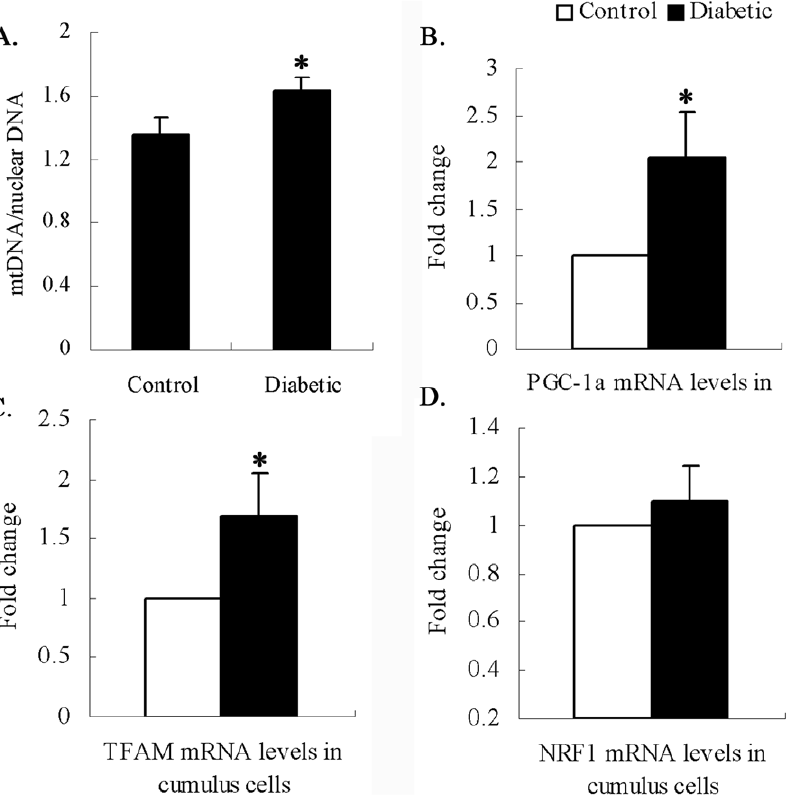
Figure 4. Increased mitochondrial biogenesis in cumulus cells of diabetic mice. Cumulus cells removed from cumulus-oocyte complexes were collected for analysis. (A) mtDNA content was calculated using quantitative real-time PCR by measuring the ratio of cytochrome b (mitochondrial gene) to b -actin (nuclear gene) DNA levels in cumulus cells of control and diabetic mice. (B–D) mRNA levels of genes implicated in mitochondrial biogenesis determined by real-time RT-PCR in cumulus cells from control and diabetic mice. At least three experiments were performed and data are presented as the mean 6 SD of the fold changes. * p , 0.05 vs control.